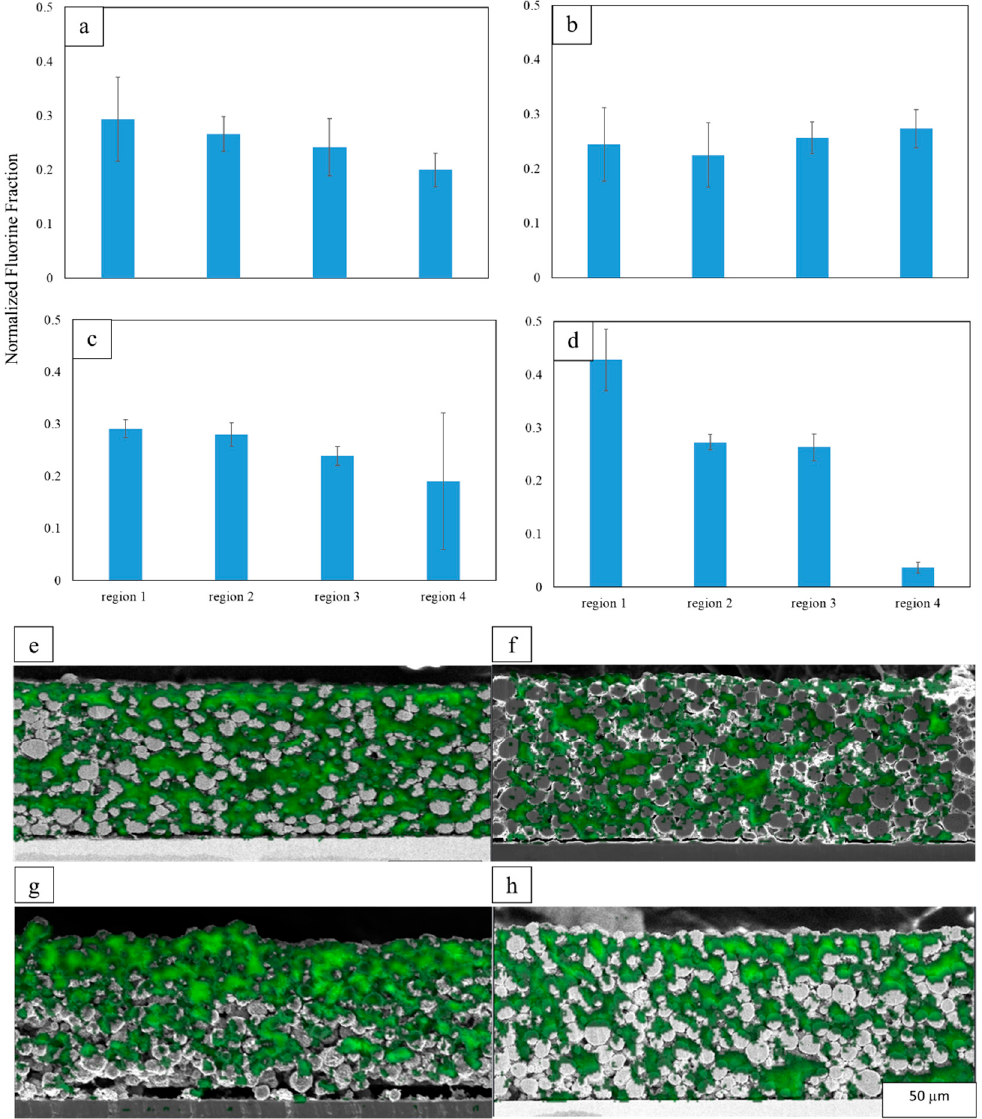
Figure 7. Normalized fluorine fraction at four regions (1 is at the top and 4 at the bottom), and fluorine maps of uncalendered cathodes at different drying temperatures of: ( a , e ) 24 °C; ( b , f ) 80 °C; ( c , g ) 150 °C; ( d , h ) 232 °C.